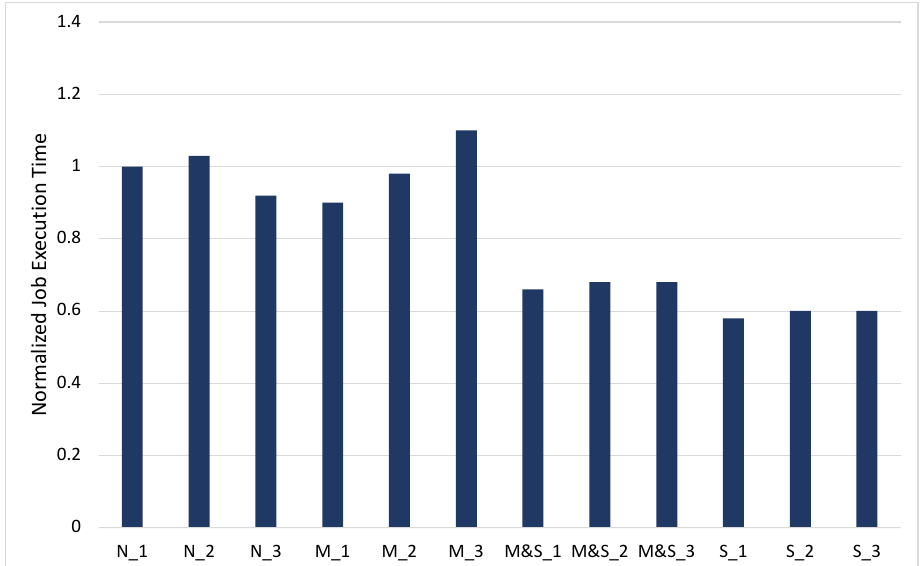
Figure 7. The normalized TC job execution